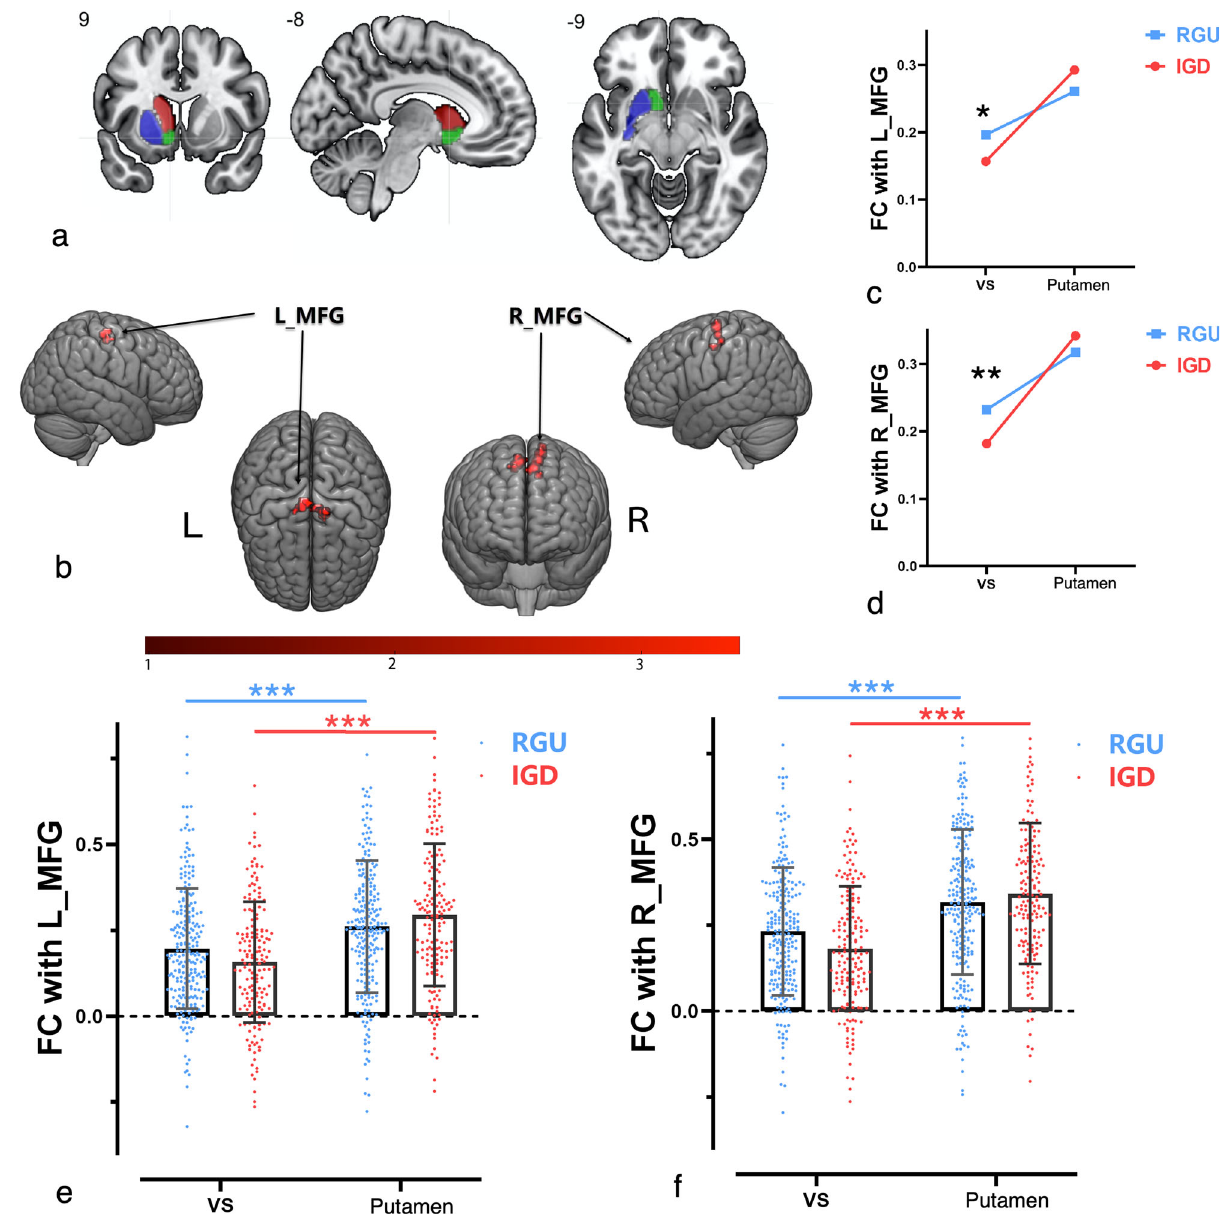
Fig. 1 Interactions were found between ventral/dorsal striatum and the MFG. a ROIs selected for the ventral and dorsal striatum in the current study. Left hemispheric regions are shown. Green: NAcc; Red: Caudate; Blue: Putaman. b Brain regions that show functional connectivity interactions with the ventral/ dorsal striatum seeds and diagnostic groups. c , d Plots demonstrating the interaction on functional connectivity strength between ventral striatum/ putamen and left and right MFG in IGD and RGU subjects. e , f Strength of the functional connectivity between the VS/putamen and left or right MFG in IGD and RGU subjects. IGD: 174 subjects; RGU: 244 subjects. * p < 0.05; ** p < 0.01. Table 1 Results that show functional connectivity interactions between the VS and DS in the current study. ROI Cluster Peak MNI coordinates Peak intensity Cluster size Region AAL X Y Z Left, Putamen- Accumbens 1 12 − 15 63 4.58 55 R Medial Frontal Gyrus Supp_Motor_Area_R 2 − 9 − 24 57 4.3246 37 L Medial Frontal Gyrus Supp_Motor_Area_L All images are thresholded at p <0.05, TFCE-corrected; Iterations = 5000. MNI Montreal Neurological Institute, AAL anatomical automatic labelling, TFCE threshold-free clustering enhancement.